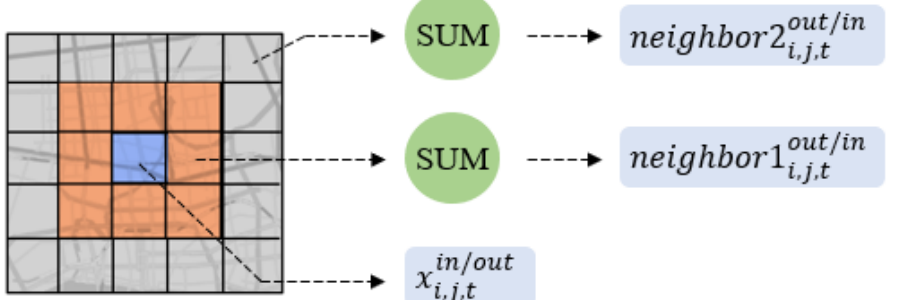
Figure 5. Spatial-temporal dependent data extracted from maps.